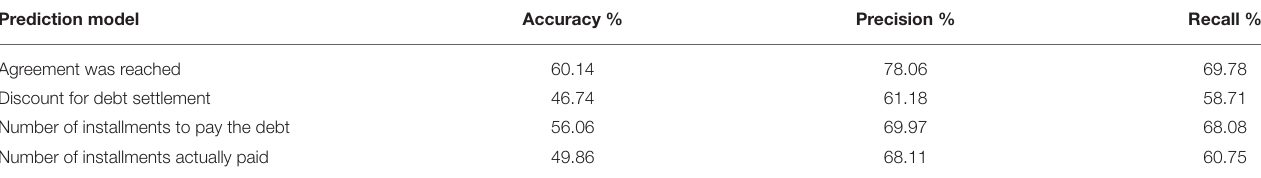
TABLE 8 | Prediction model